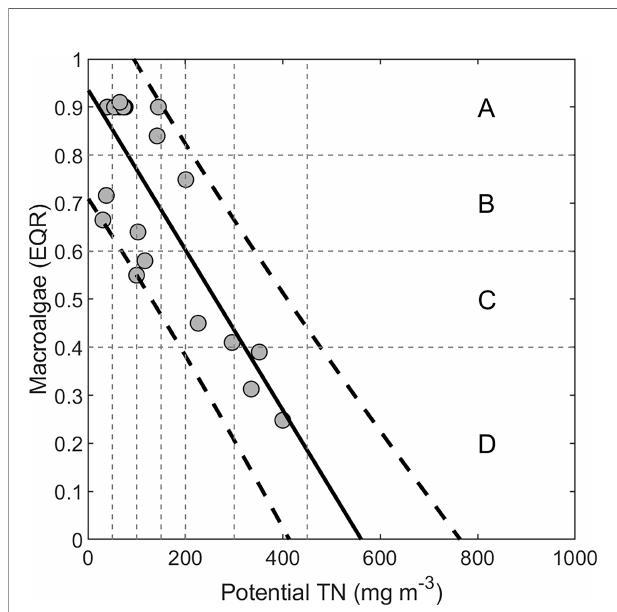
FIGURE 2 | Observations of macroalgae Ecological Quality Rating (EQR) plotted against potential total nitrogen (TN) concentrations for 21 NZ estuaries. Data were from Robertson et al. (2016b); Plew et al. (2018) and Plew et al. (2020). Horizontal dotted lines demark thresholds between EQR bands (A – D) for macroalgae. Also shown are 95% prediction intervals (dashed lines) used for calculating proportion of observations in each EQR band at various potential TN levels (vertical